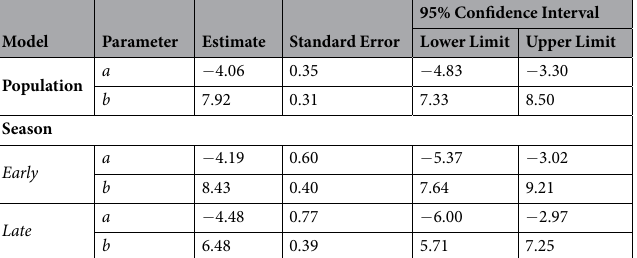
Table 2. Parameter estimates for the population and season models. Note: a denotes the Hill Coefficient, the steepness of the reaction norm. b denotes the effective dose, the duration of exposure (days) to female producing conditions required to produce 50% females.